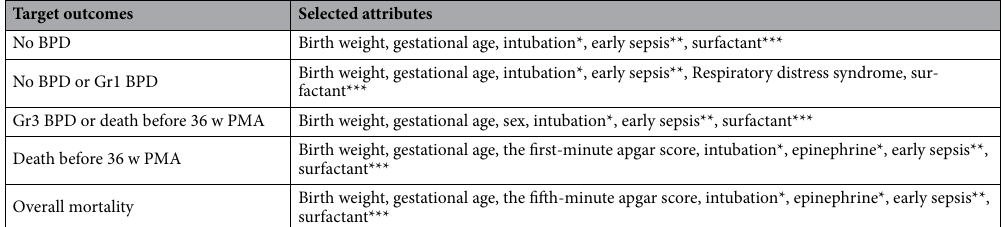
Table 3. AUROC values of each model developed using various algorithms and training and testing data sets, and AUROC values of logistic regression after attribute selection using training and testing sets (Italic Data). AUROC Area under the receiver operating characteristic curve; BPD Bronchopulmonary dysplasia; kNN k-nearest neighbors; Gr Grade; PMA Postmenstrual age; SVM Support vector machine.